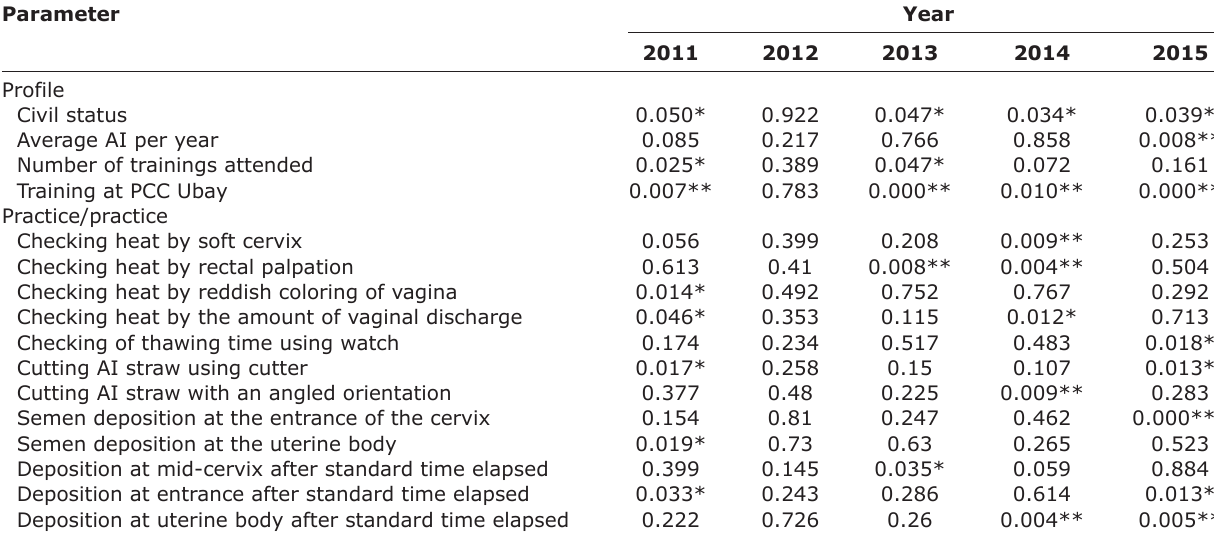
Table-4: Results of statistical analyses with significant results (p